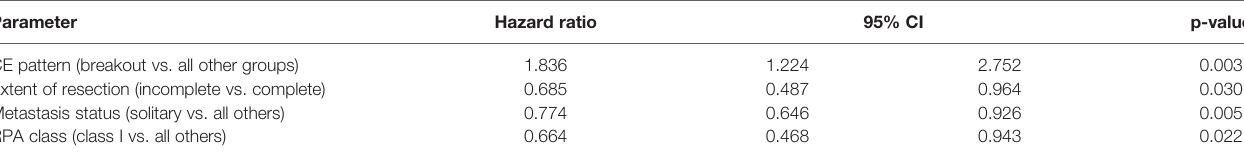
TABLE 6 | Multivariate analysis of independent factors associated with overall survival. Parameter Hazard ratio CE pattern (breakout vs. all other